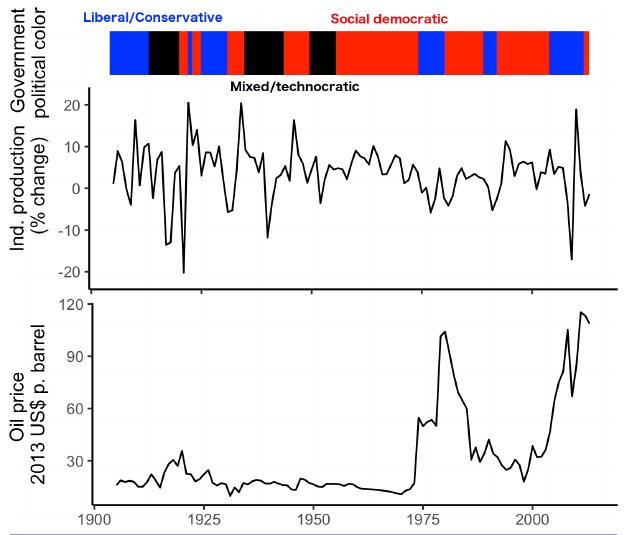
Fig. 7 . Independent variables used to investigate drivers behind changes in